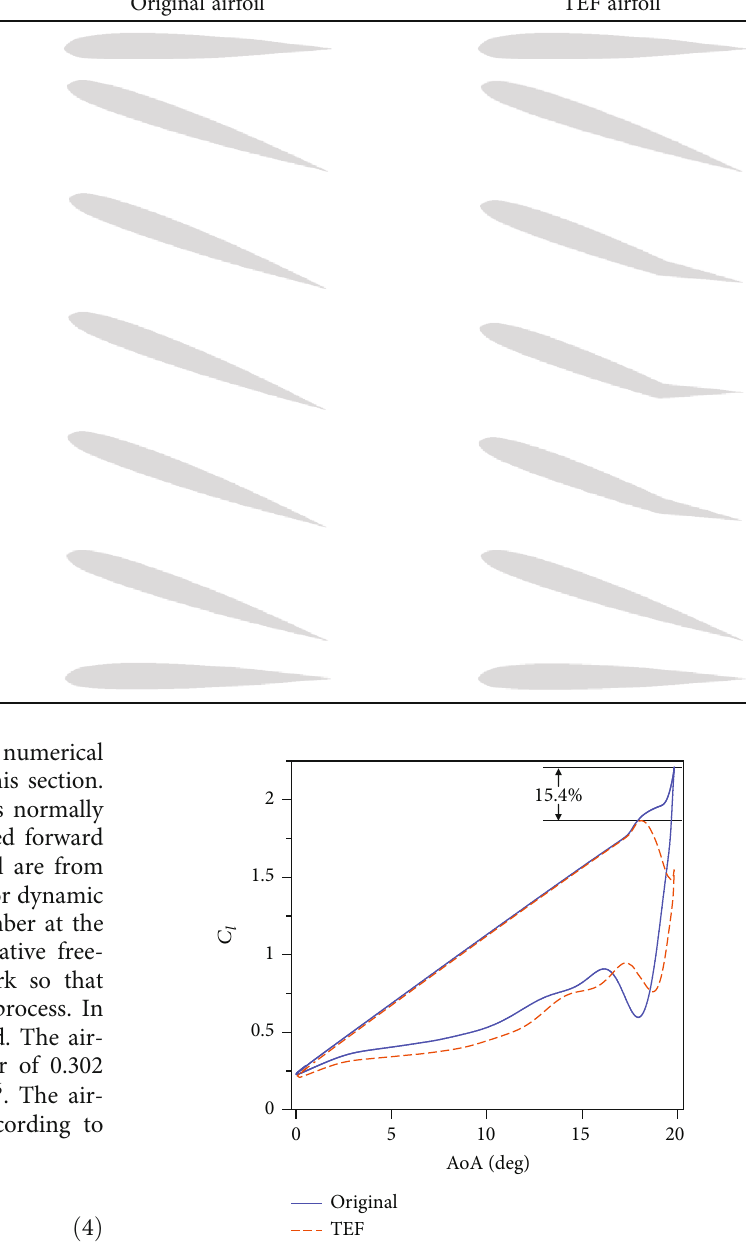
Figure 9: Comparison of lift coe ffi cients between the original and TEF